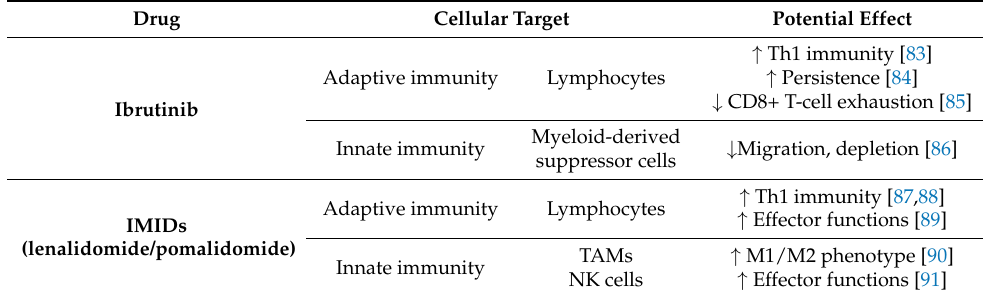
Table 2. Potential “on-target, off-tumor” effects of ibrutinib and